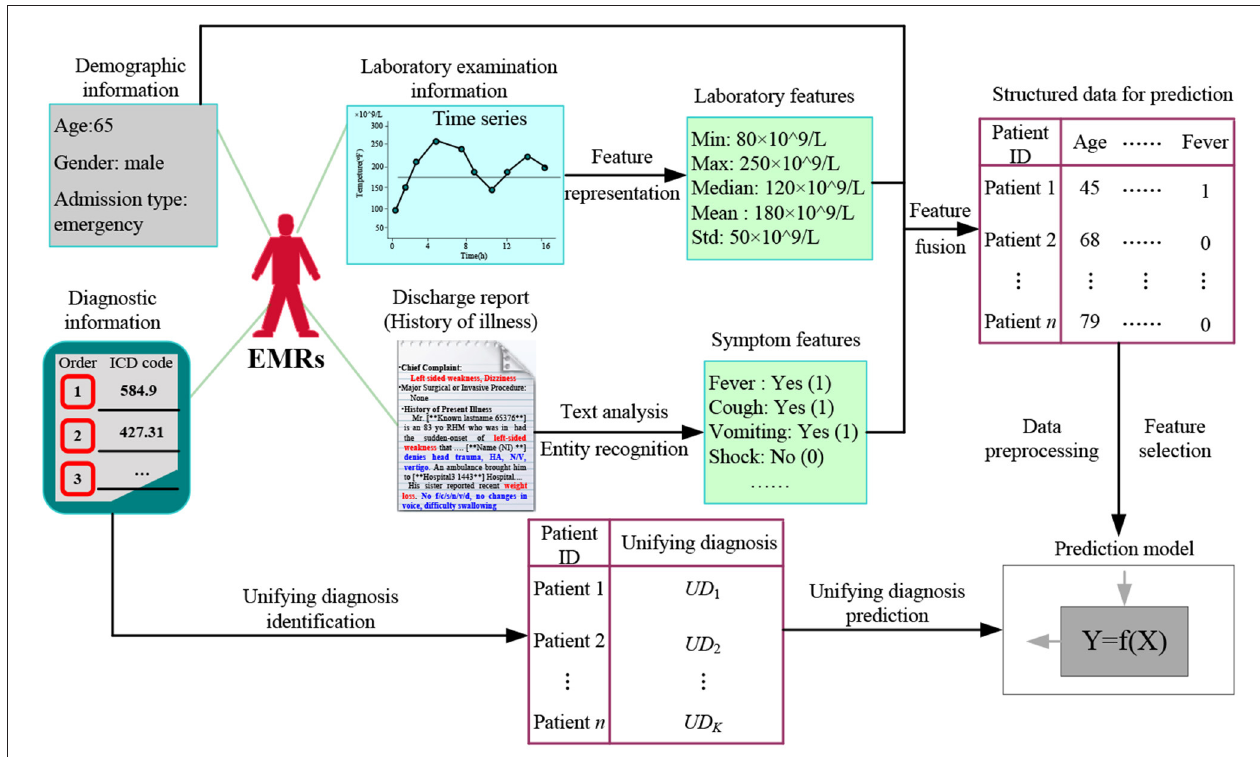
FIGURE 6 | Proposed UD prediction